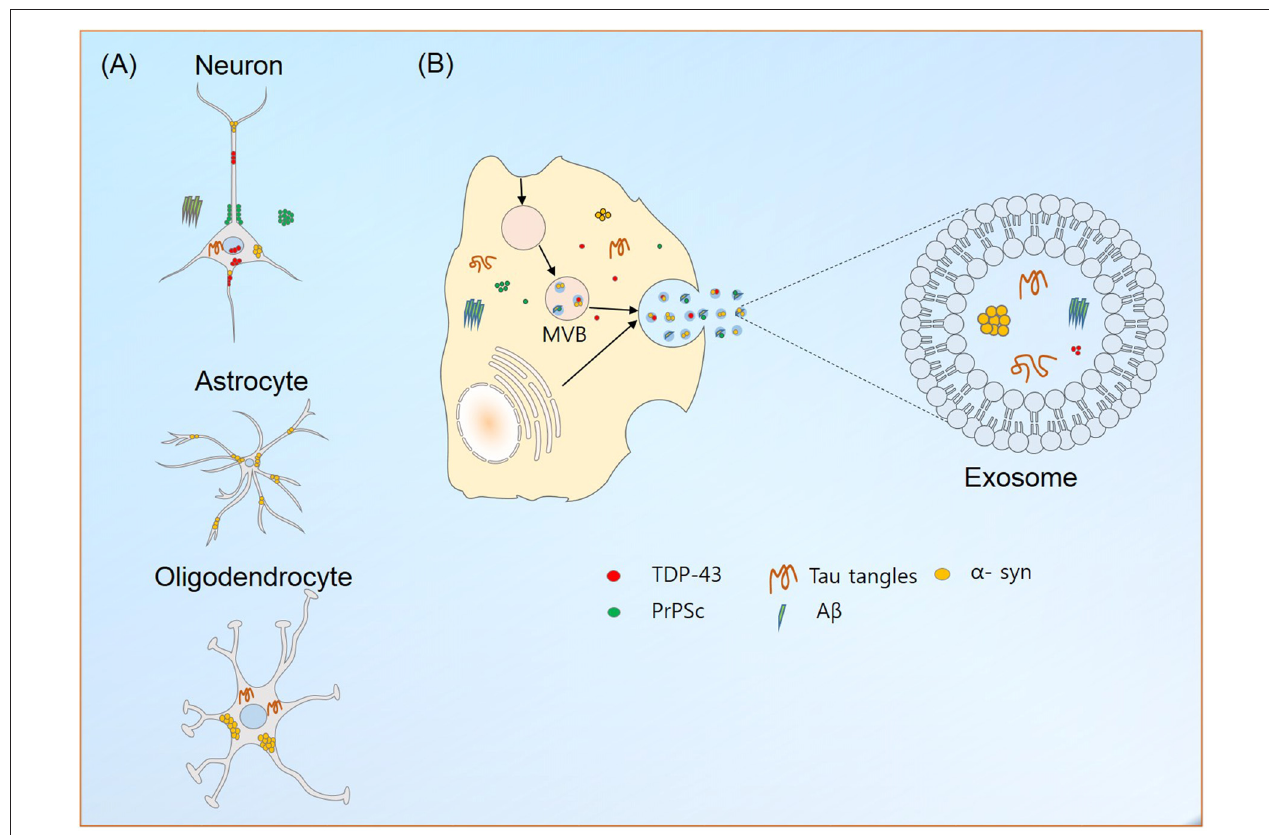
FIGURE 1 | Exosome production and neurodegeneration. (A) Localization of aggregated or misfolded proteins credited for their roles in the neurodegeneration in different neuronal cells. (B) Exosome production in neuronal cells. The abilities of exosomes to carry disease causing entities to neighboring and distant localized cells contributes to the aggravation of neurological diseases. Similarly, their transport across blood brain barrier (BBB) helps in reducing the possible emergence of different neurological